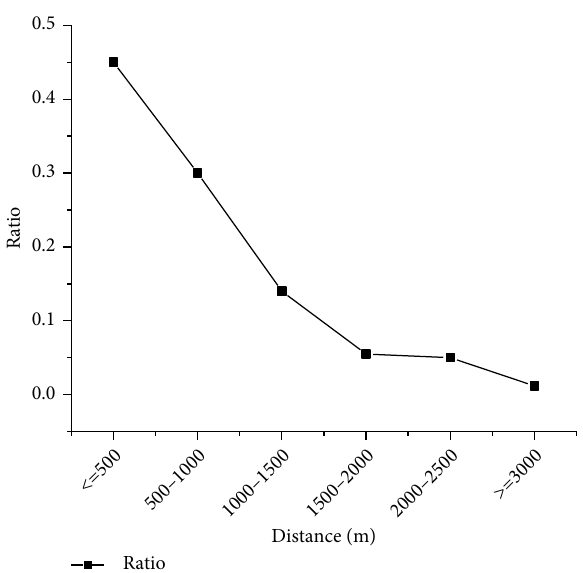
Figure 23: Variation with distance of population coverage of primary and secondary school in the central urban